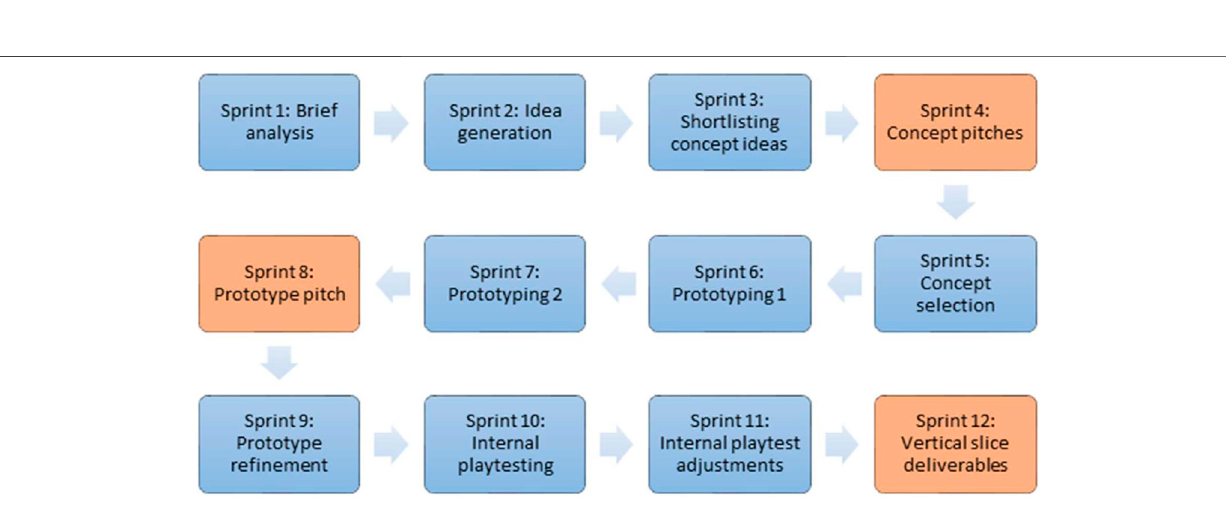
Frontiers in Built Environment |